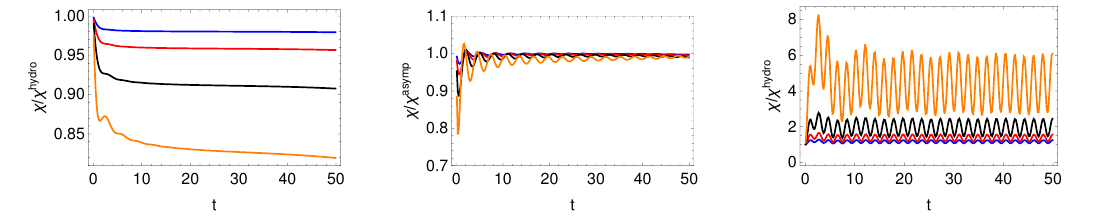
Figure 1: Left and right: the ratio R ( t ) of the exact FCS (8) to the hydrodynamic contribution (18) for the full initial filling and different hopping constants at the link, (cid:34) = 0.3 (left) and (cid:34) = 3.0 (right). These plots illustrate that at large times R ( t ) saturates for (cid:34) < 1 and oscillates around some average value for (cid:34) > 1. Center: the ratio of the exact FCS (8) to the exact large time asymptotics (20) for (cid:34) = 1 and the full initial filling. At small times one can see transient oscillations which get completely damped at large times. Blue, red, black and orange curves correspond to respectively λ = 0.25,0.5,1,2 in all three